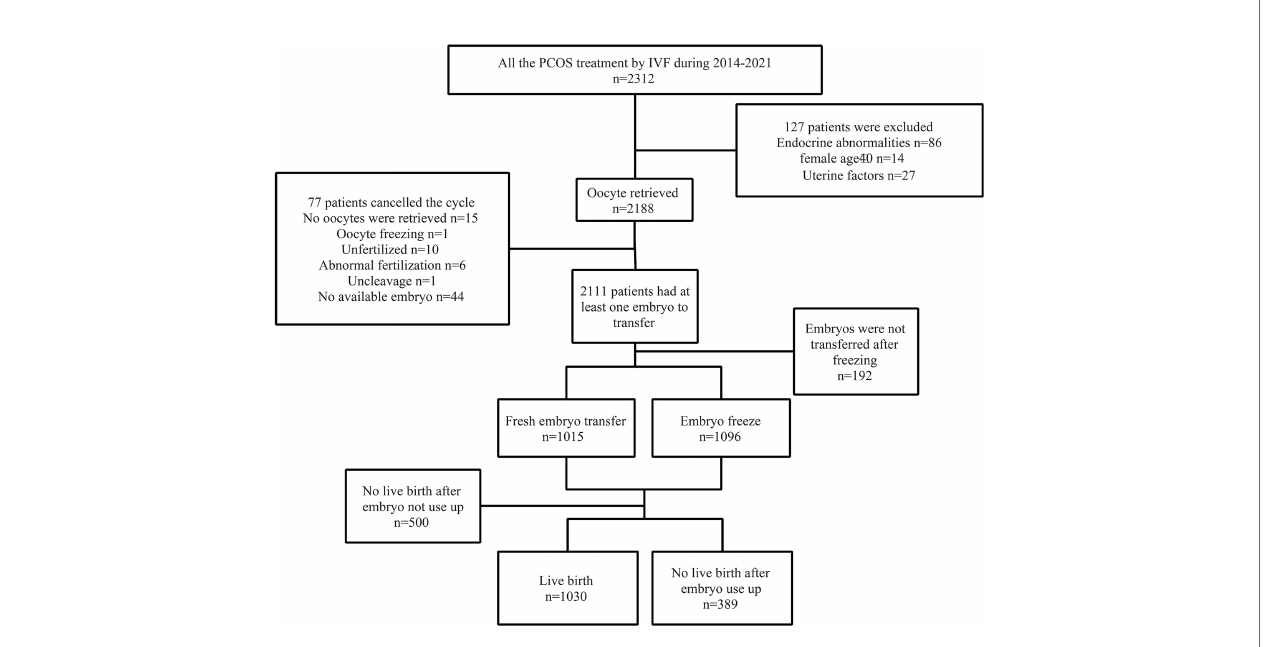
FIGURE 1 | Test fl ow chart. Patient selection and cycle